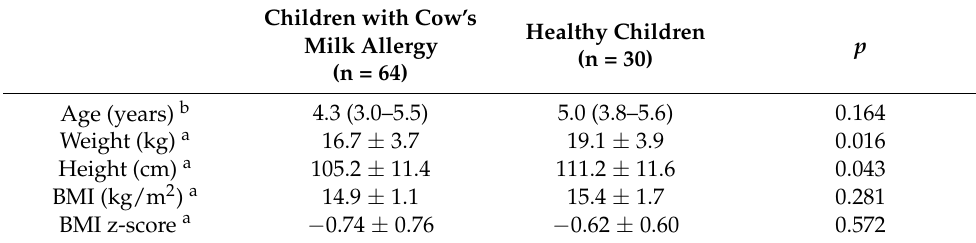
Table 1. Baseline characteristics of the study